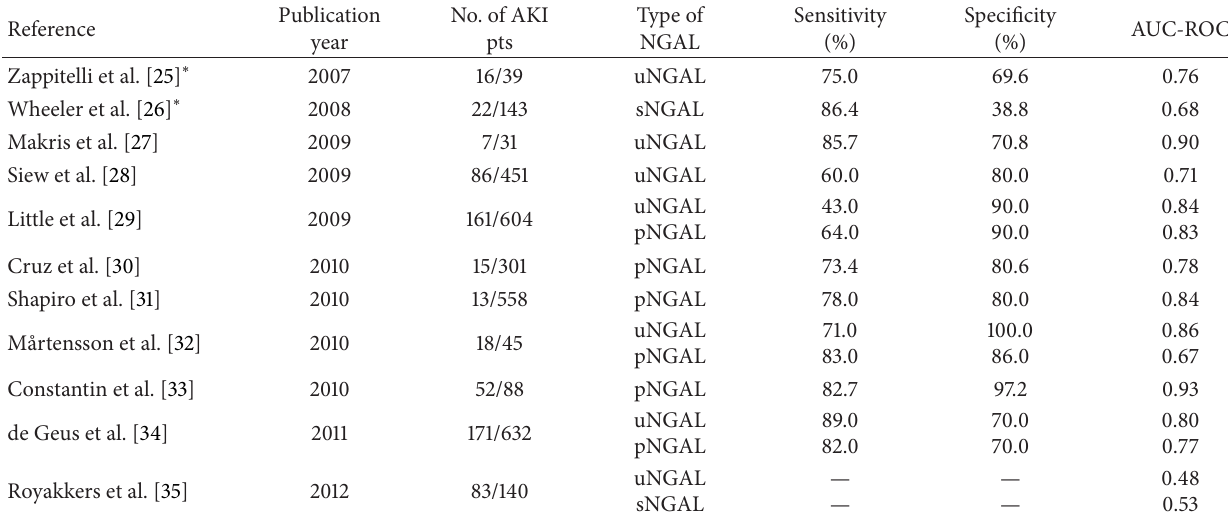
Table 2: NGAL for prediction of AKI in mixed ICU